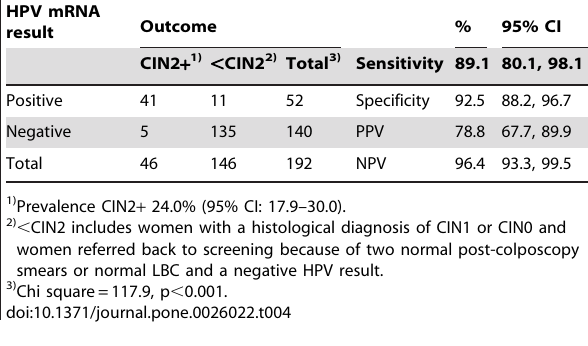
Table 6. Outcome for the 192 women in the HPV group if triaged with post-colposcopy HPV mRNA combined with cytology when cut-off is ASC-H +